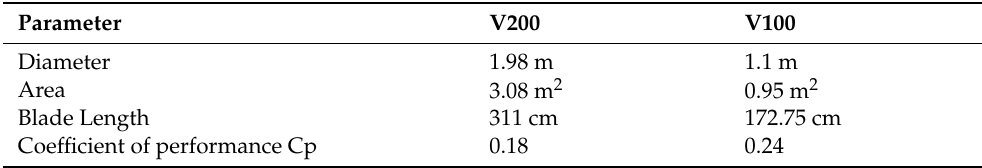
Table 3. V100 and V200 EBWT specifications.